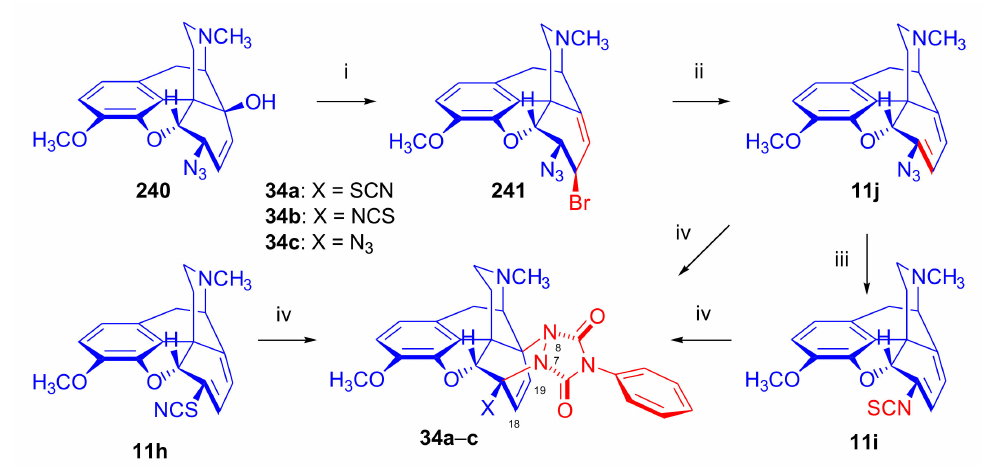
Figure 67. Synthesis of PTAD adducts of 6-substituted-6-demethoxythebaine derivatives. Reagents and conditions : (i). PBr 3 , CHCl 3 , 50 ◦ C, 2 h; 77%; (ii): KO t Bu, ethanol, room temperature, 30 min, 75%; (iii): CS2, TPP, reflux, 2 h, 51%; and (iv): PTAD, acetone, room temperature, 20 min,